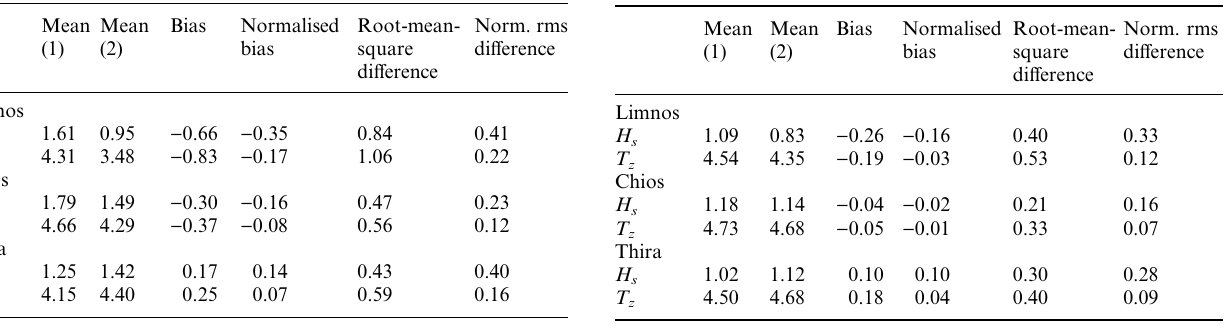
Table 7. Statistics for the storm January 1991, -136 points. Comparison of results from WAM model using UKMO and ECMWF winds